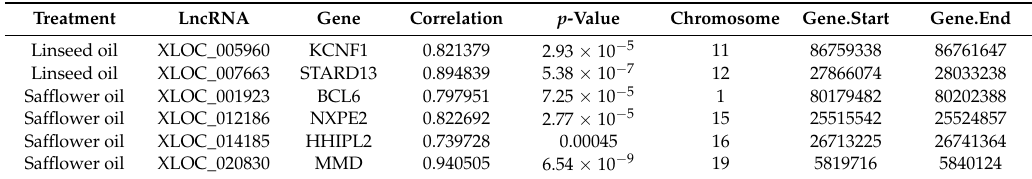
Figure 4. Unique and common significantly ( p -value BH < 0.1) differentially expressed lncRNAs between periods of comparison. Table 5. Potential cis target genes for differentially expressed lncRNAs in linseed oil and safflower oil treatments.